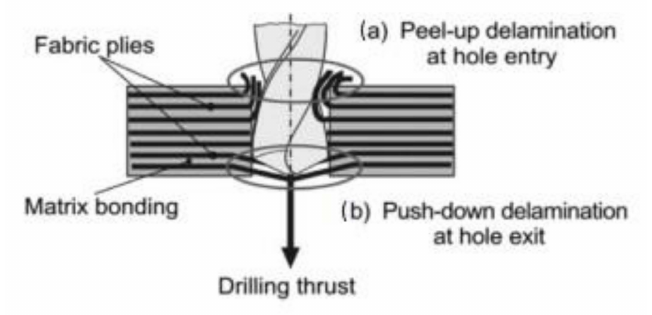
Figure 7. Peel-up ( a ) and push-out ( b ) delaminations [87].